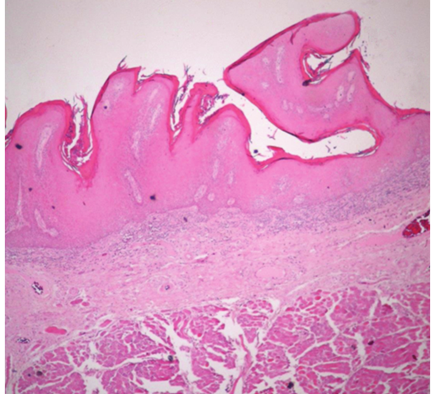
Figure 1: Photomicrograph of verrucous hyperplasia showing sharp surface projections (original magnification 4x, H and E